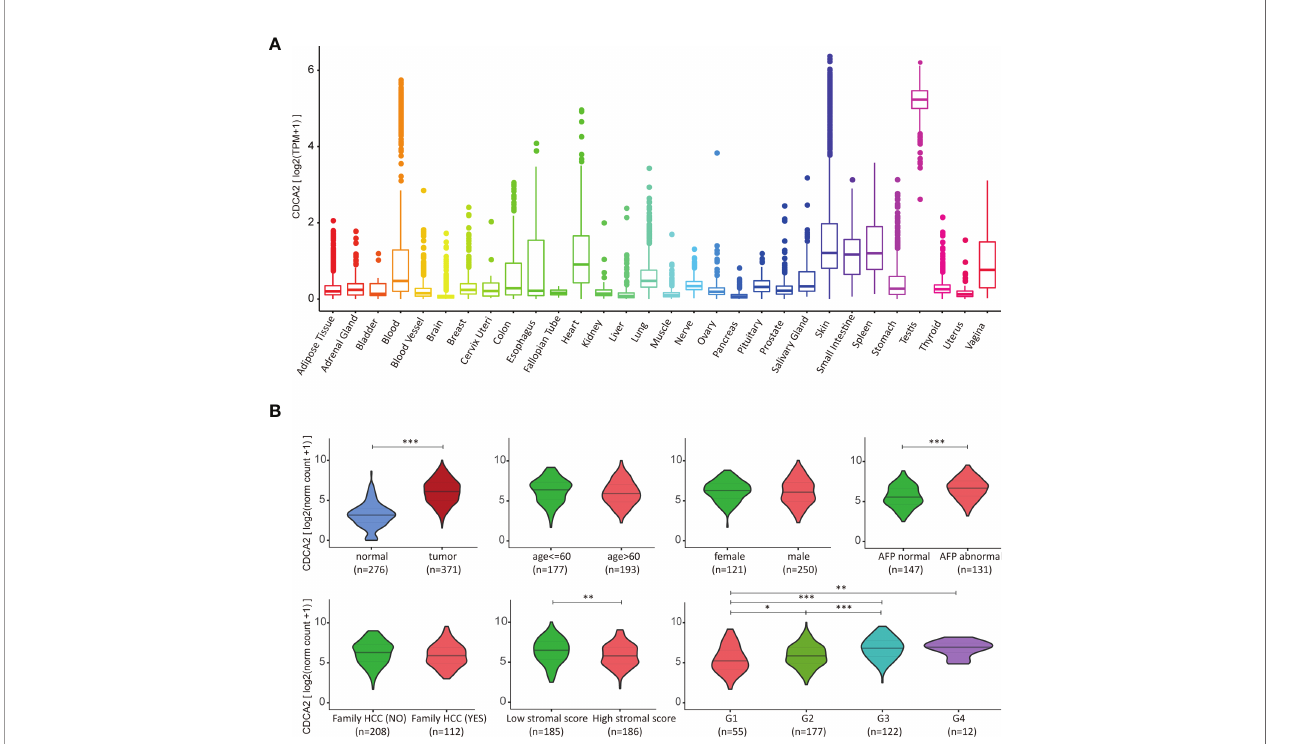
FIGURE 3 | Cell division cycle associated 2 (CDCA2) correlated with hepatocellular carcinoma (HCC). (A) Gene expression of CDCA2 in normal human organs from the Genotype-Tissue Expression (GTEx) database. (B) Correlation analysis of CDCA2 with clinical indicators in The Cancer Genome Atlas (TCGA) cases and ESTIMATE database. *p < 0.05, **p < 0.01, ***p <